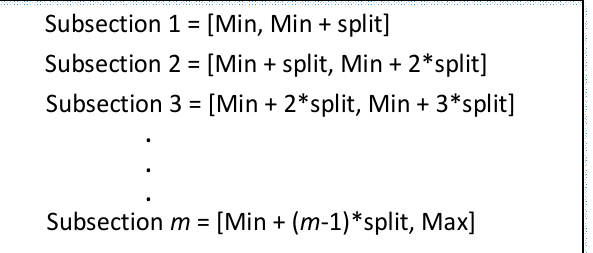
Figure 4. The span of m